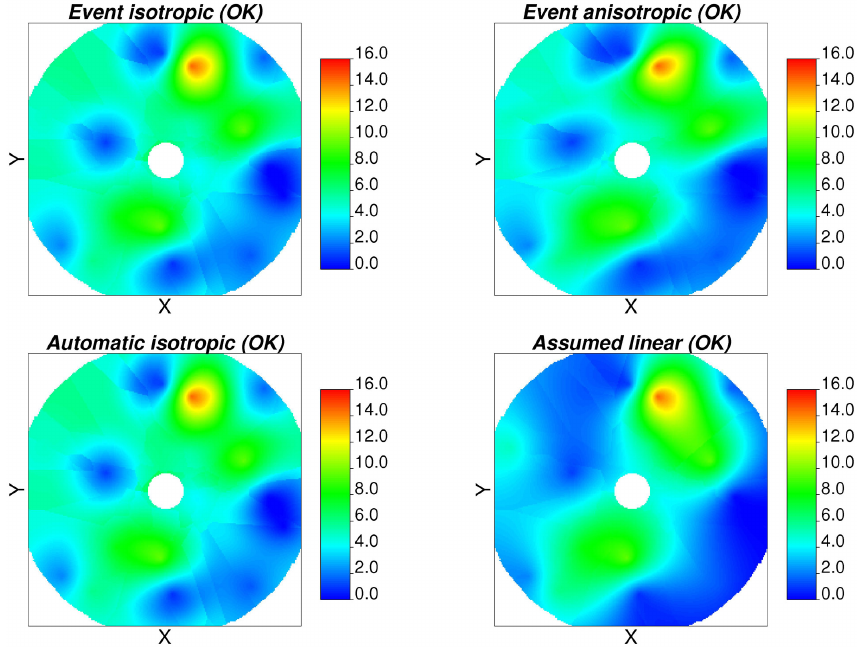
Fig. 6. Spatial distribution of precipitation in mmh − 1 for one hour between 06:00p.m. and 07:00p.m. on the 19 July 2002 interpolated with OK, but different semivariogram